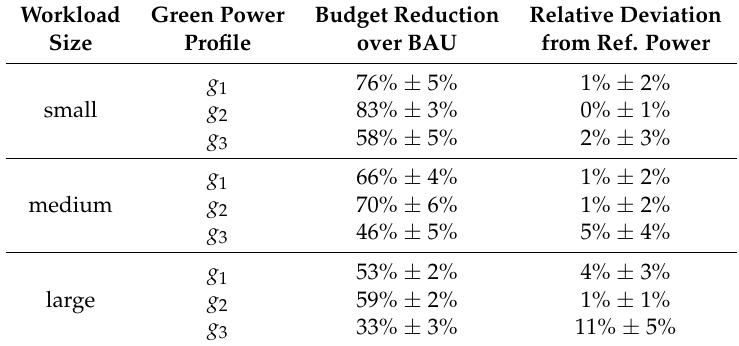
Table 4. Average and standard deviation for the relative budget reduction over the business-as-usual scenario (BAU), and relative deviation from the reference power computed by ev-MOGA for quality of service over 95%.